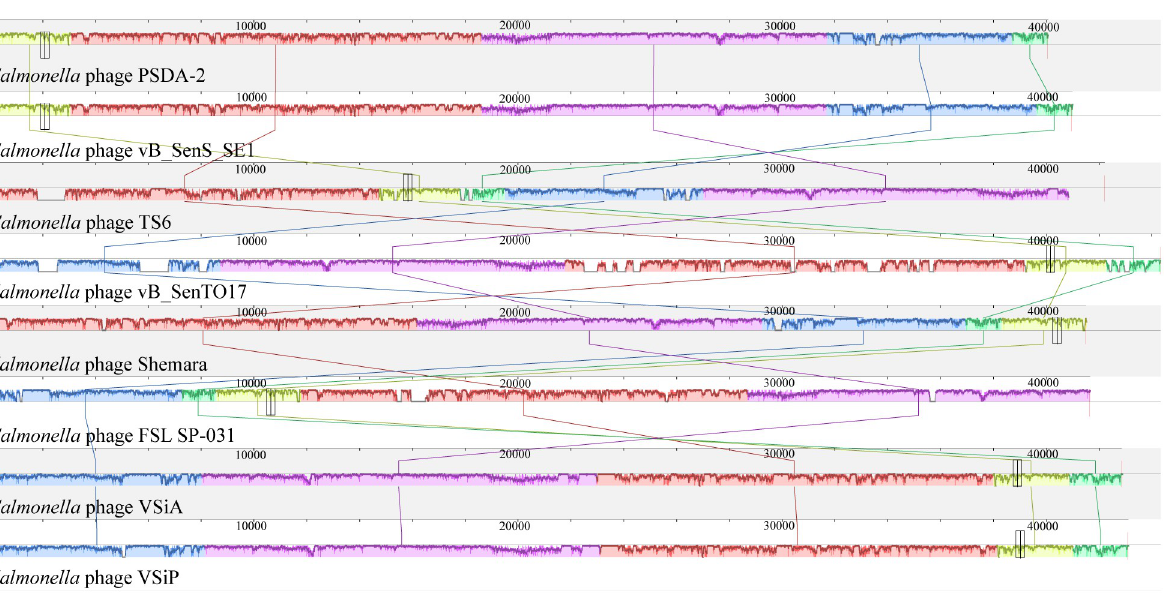
Fig 5. Progressive MAUVE alignment of PSDA-2 and homologous phages genome. Boxes with identical colors are homologous DNA regions shared by the chromosomes.